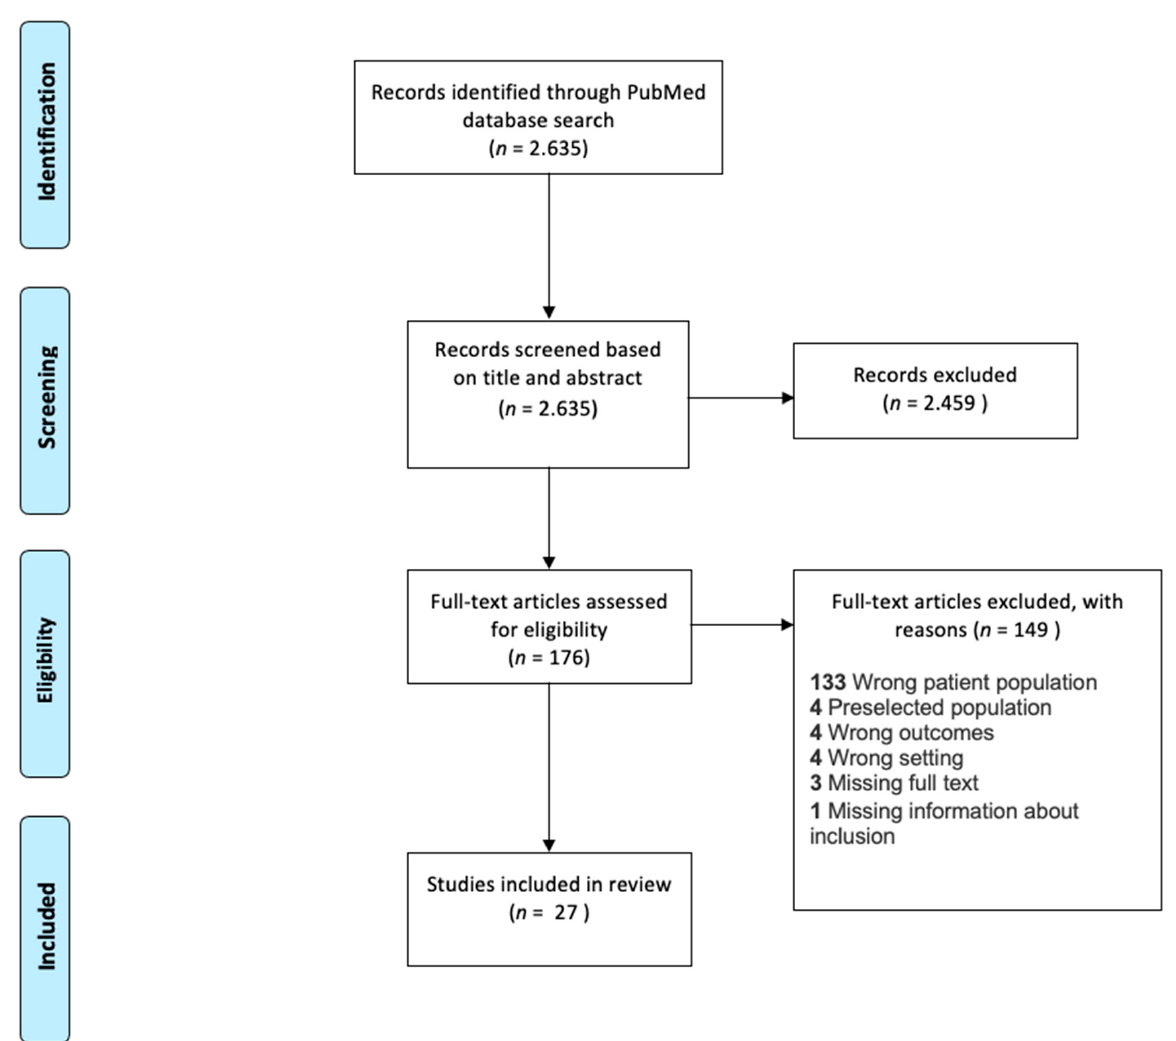
Figure 1. PRISMA flowchart. Studies identified through PubMed 14 July 2020. Studies were first reviewed based on title and abstract, which excluded 2459 studies. 176 studies were eligible for full-text review, and 149 studies were then excluded, mostly due to wrong patient population. 27 studies were included in this systematic review for data extraction and meta-analysis.